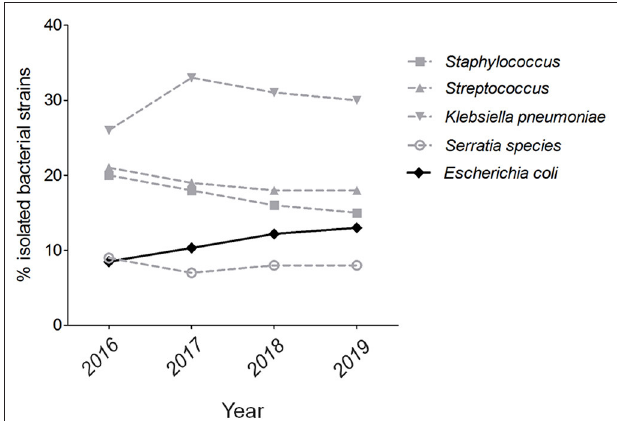
FIGURE 1 | The isolation rate of E. coli strains on bovine mastitis in China. The isolation rates of five mainly pathogenic species in bovine mastitis from 2016 to 2019.